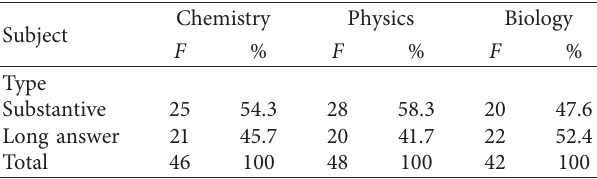
Table 6: Final examinations’ grade distribution for chemistry, physics, and biology based on type.